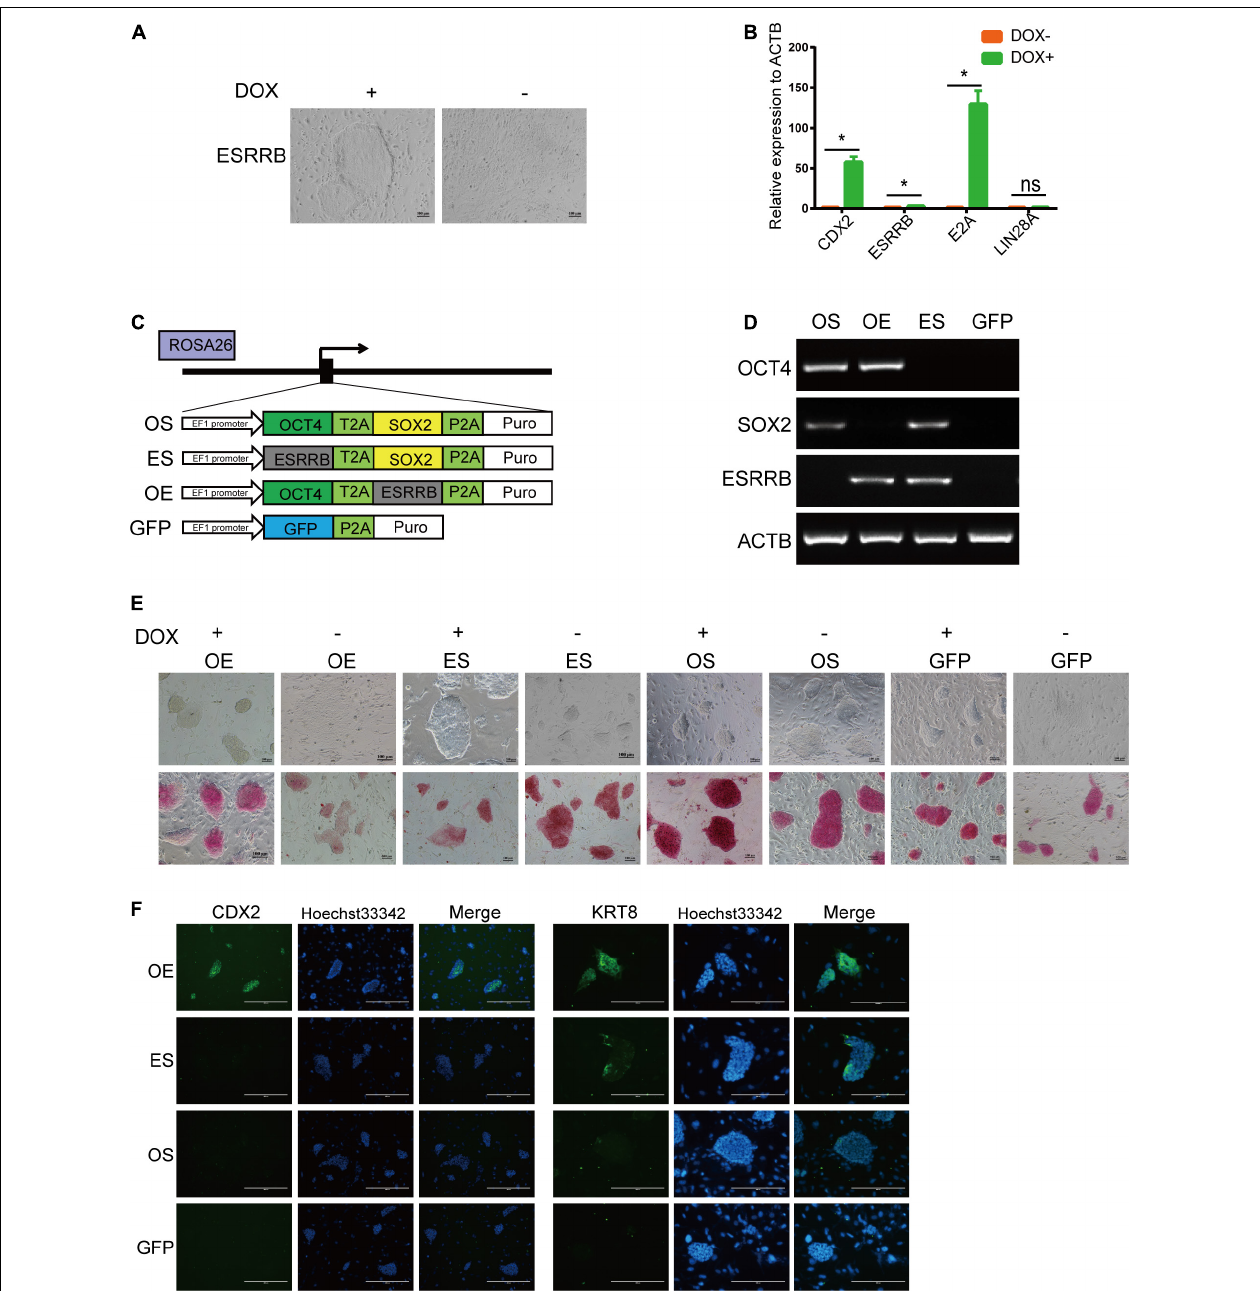
FIGURE 5 | CDX2 expression was modulated by both OCT4 and ESRRB. (A) Representative image of colonies after doxycycline (DOX) withdrawal. * p < 0.05; (B) qRT-PCR analysis of CDX2 , ESRRB , E2A , and LIN28A in the DOX and DOX-withdrawal groups. (C) A schematic illustration of different combination of ESRRB and OCT4 (OE), ESRRB and SOX2 (ES), OCT4 and SOX2 (OS), and GFP constructs to be inserted into the ROSA26 site. (D) RT-PCR analysis of the expressions of ESRRB and porcine-specific exogenous OCT4 , SOX2 , and ACTB in the OS, OE, ES, and GFP cells. (E) Representative image of AP-stained colonies of the four constructed cell lines with DOX or after DOX withdrawal after 5 days. The scale bar represents 100 µ m. (F) Immunofluorescence analysis of CDX2 and KRT8 in the four constructed cell lines without DOX. The scale bar represents 200 µ